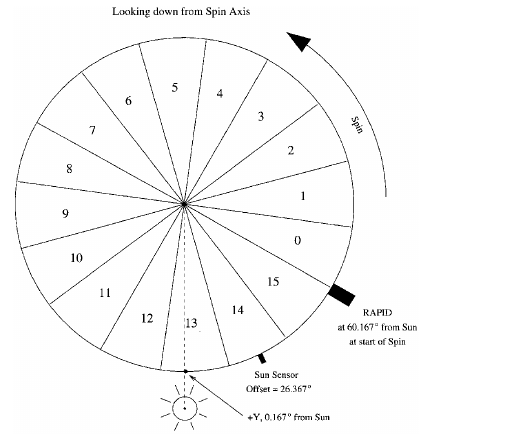
Fig. 1. Azimuthal (left figure) and polar (right figure) sectoring scheme of RAPID.